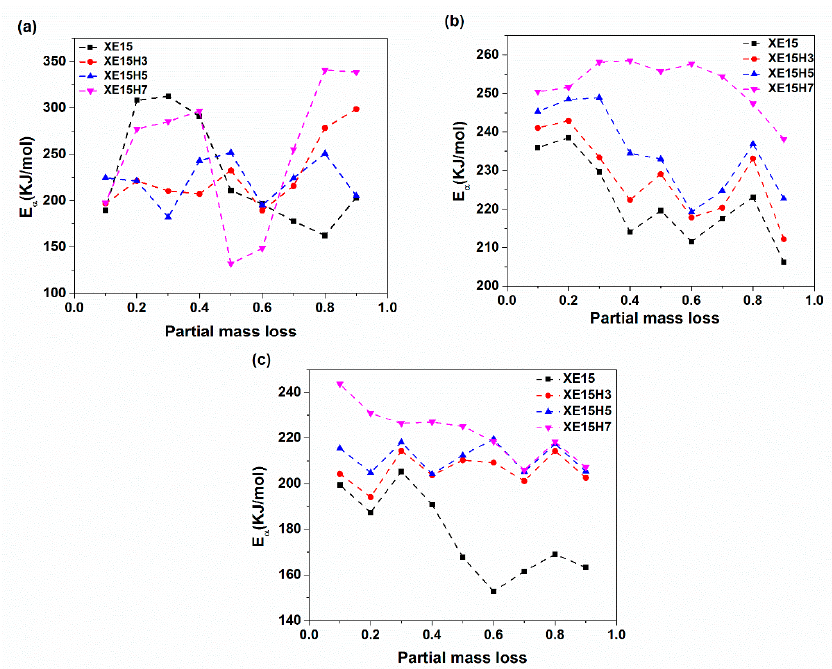
Figure 14. Variation of activation energy with the partial mass loss parameter and XHNT concentration calculated through using ( a ) Friedman ( b ) KAS and ( c ) OFW methods.